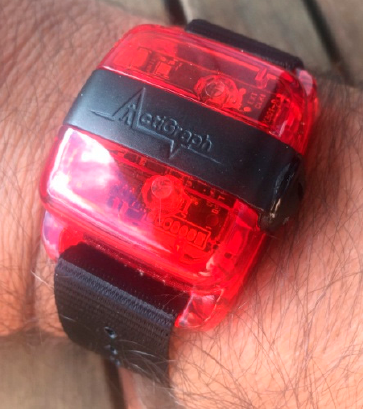
Figure 8. Actigraph GT9X.